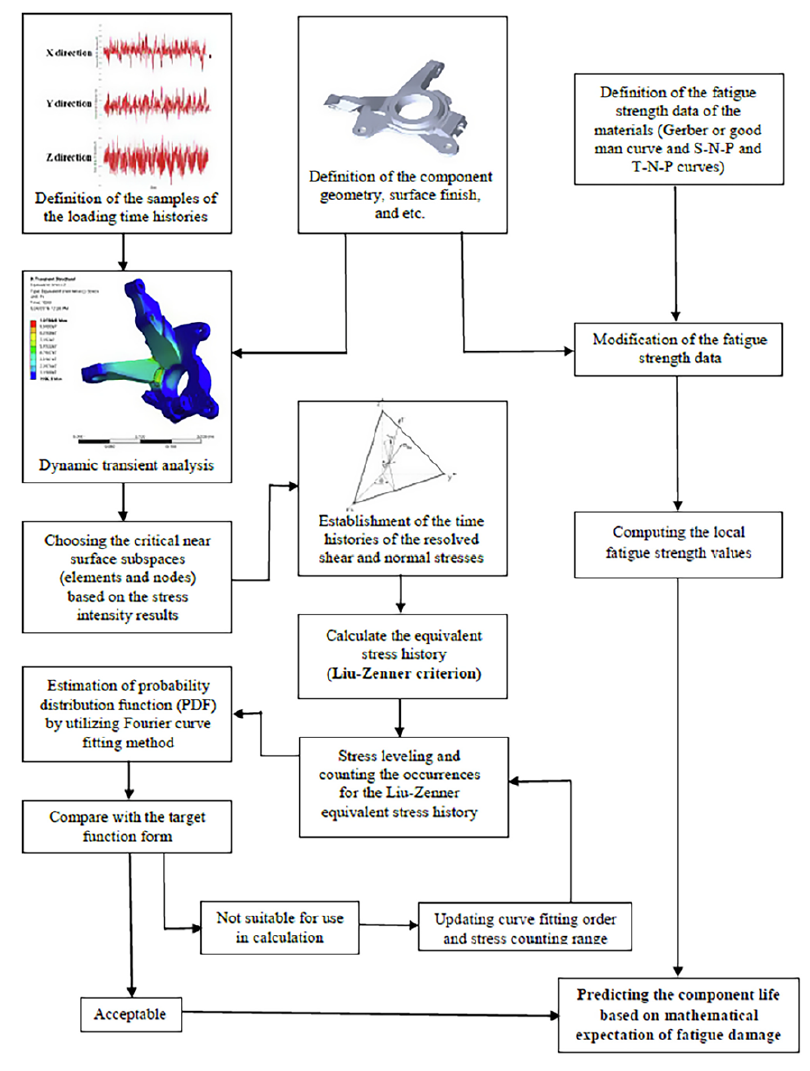
Figure A1. Novel algorithm for estimating the fatigue life of the component based on the probabilistic approach proposed by the first author [42].